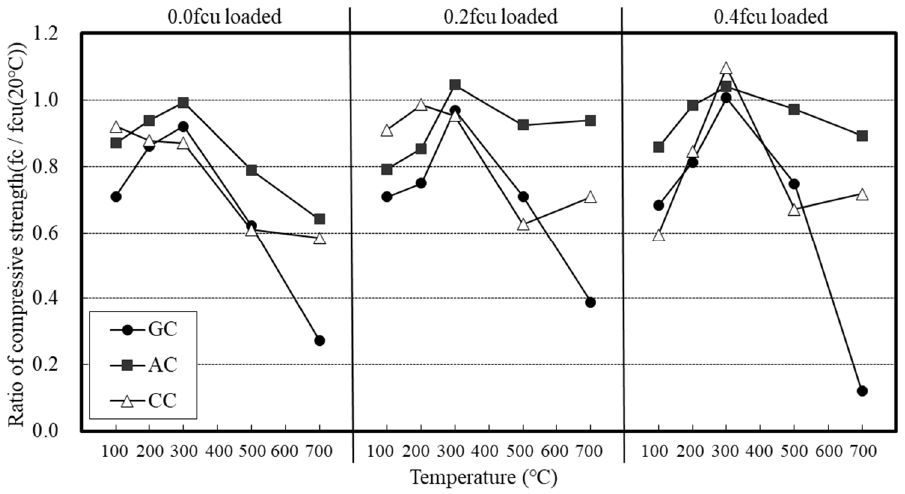
Figure 7. Relative compressive strength of the concrete with loading condition. Under the loading condition of 0.0 fcu, the GC showed the lowest residual compressive strength. In the case of the concrete that used lightweight aggregates, the AC exhibited a 1.3 to 2 times higher residual compressive strength than that of the GC at 500 ◦ C or higher. The CC showed a larger reduction in compressive strength at 100 ◦ C under a load of